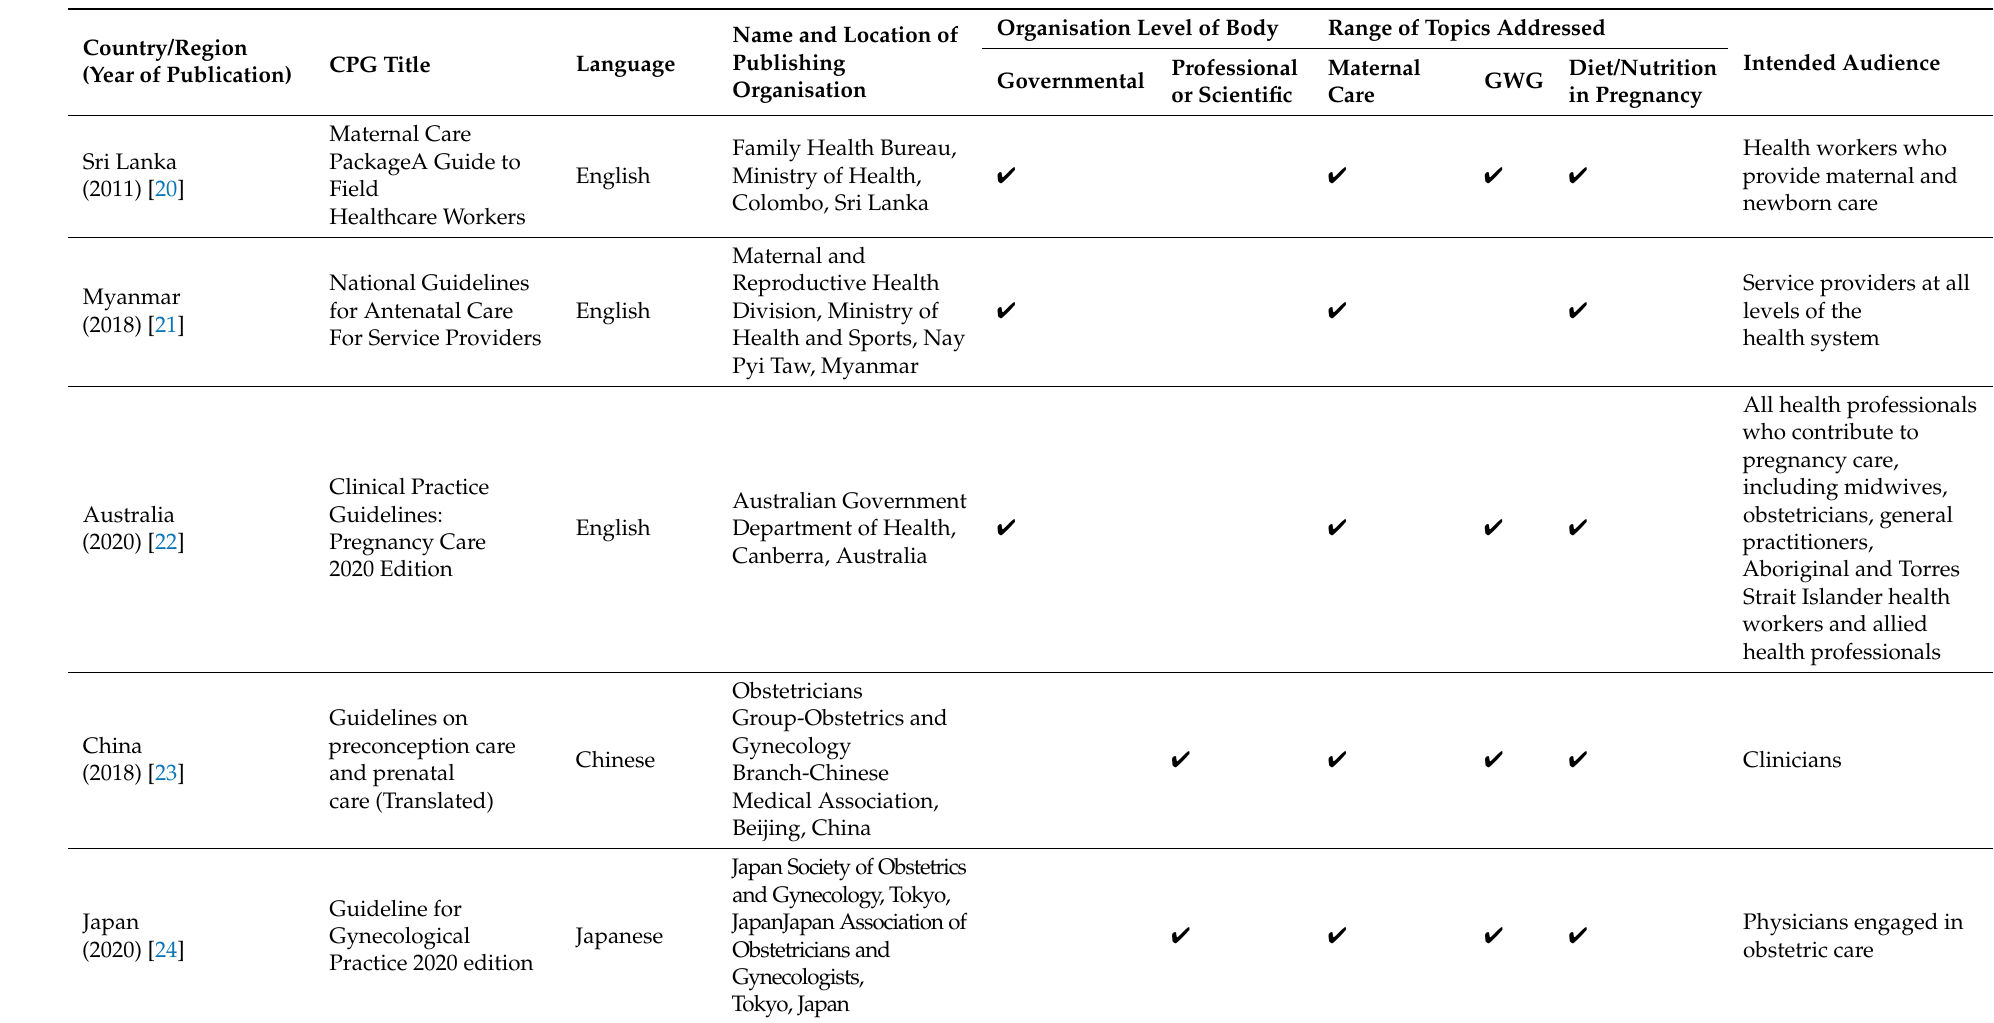
Table 2. Characteristics of the CPGs for GWG and maternal